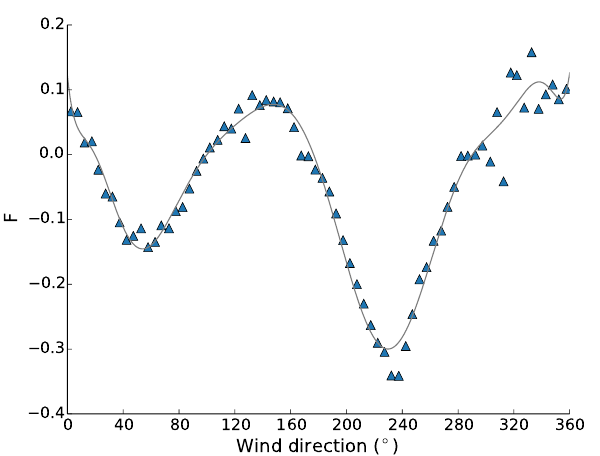
Figure 6. Calibration function F 1 for velocity class 1. Table 1. The velocity classes of the wind reconstruction algorithm. Class number